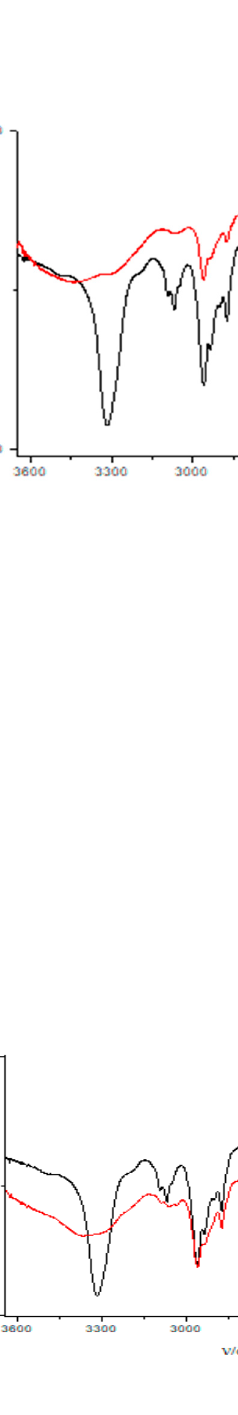
Figure 8. FTIR spectra of 1a (black) and the product of 1a /(DMF-H 2 O gel (red) ultraviolet polymerization Total spectra ( left ) and the zoom-in spectra in the range between 1400 and 800 cm − 1 ( right ).